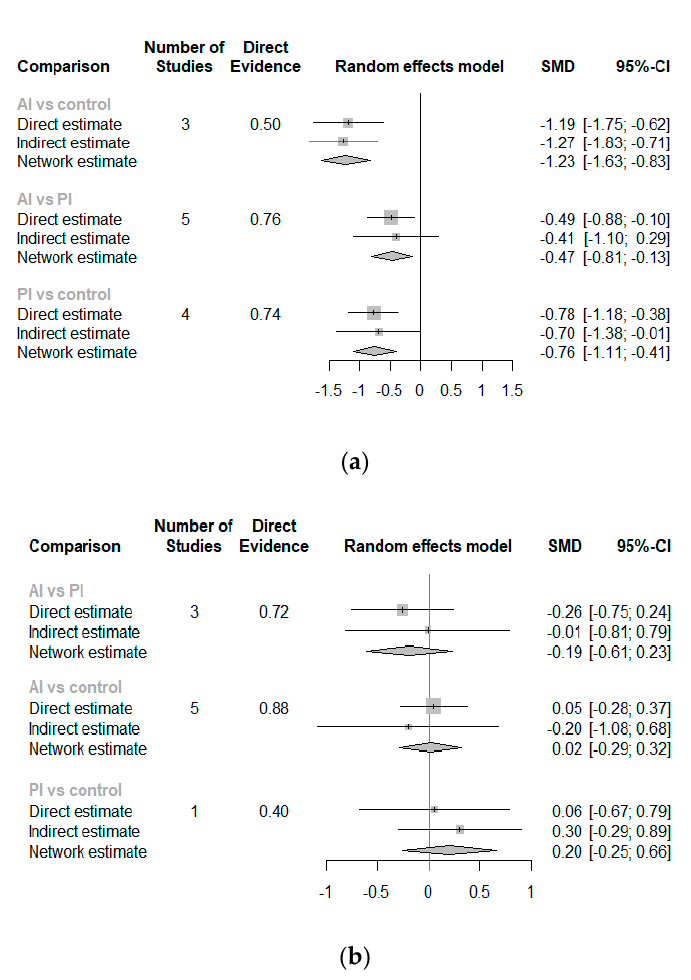
Figure 3. Forest plot of ( a ) pain and ( b ) navicular drop.